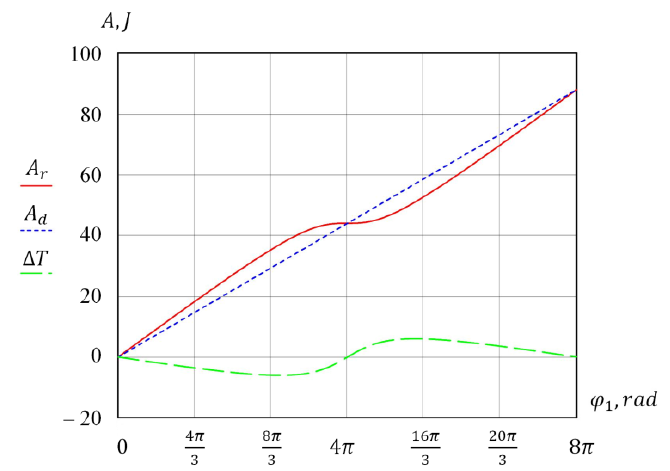
Figure 8. Graphs of functions A r ( ϕ 1 ) , A d ( ϕ 1 ) , ∆ T ( ϕ 1 ) . The angular velocity of the reduction link will be determined as [42]: